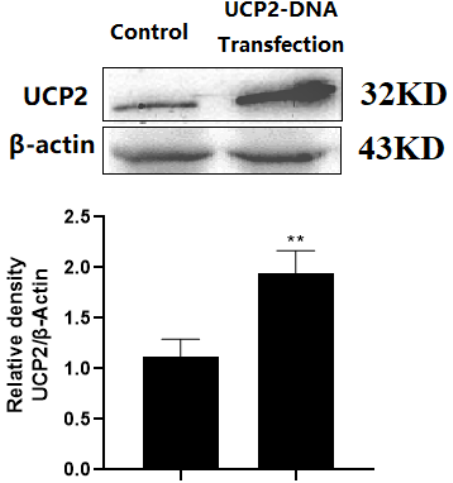
Figure 4. UCP2 expression in HK-2 cells with different treatments was detected by Western blotting. Each bar represents the mean ± SD of three independent experiments (* p < 0.05; ** p < 0.01; *** p < 0.001 vs Control group; ## p < 0.01). 2.4. The Increased Expression of UCP2 Can Reduce the Toxicity of AA I on HK-2 Cells To upregulate the expression of UCP2 in HK-2 cells, UCP2-DNA transfection using lipofectamine 2000 was performed. Figure 5 showed that UCP2 expression was successfully increased in HK-2 cells and it proved that UCP2-DNA transfection was successful.